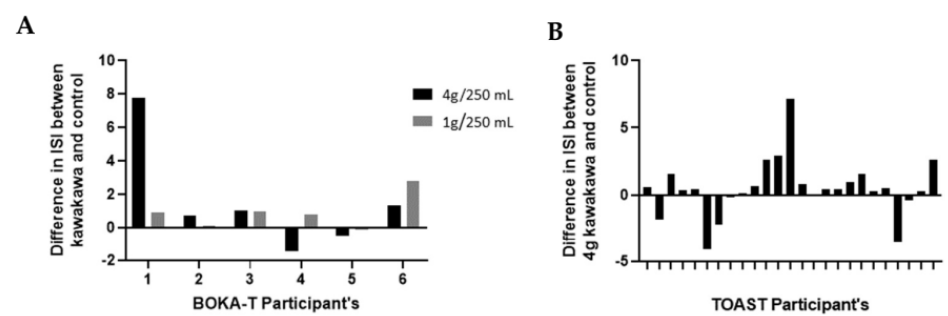
Figure 5. The difference in the insulin sensitivity index (Matsuda index) of kawakawa in comparison to control group: ( A ) BOKA_T: 4 g/250 mL kawakawa and 1 g/250 mL kawakawa in comparison to control (250 mL hot water); ( B ) TOAST: 4 g/250 mL kawakawa in comparison to control (250 mL hot